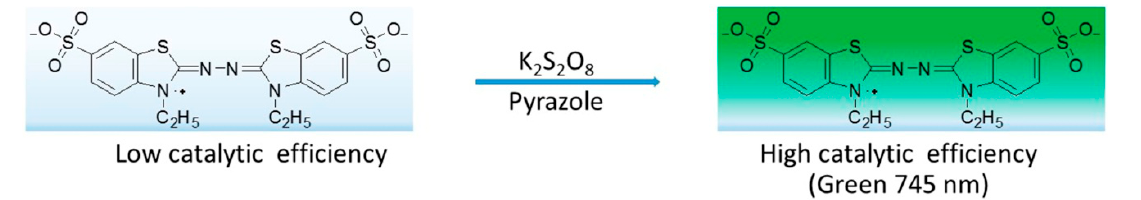
Scheme 3. Visual change of coloration in ABTS assay.